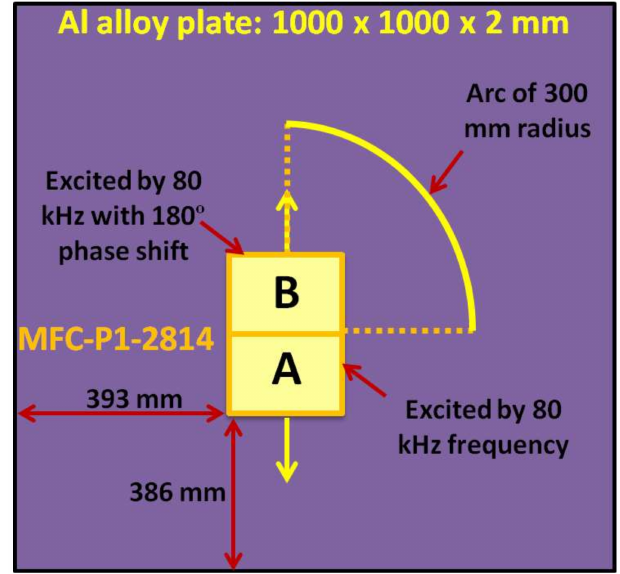
Figure 5. Description of numerical modelling of P1-type MFC transducer glued on Al alloy plate using